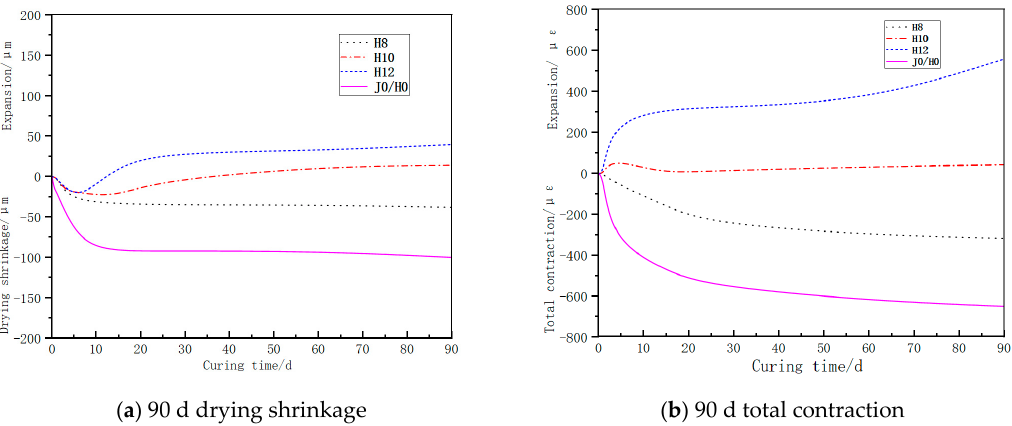
Figure 8. Effects of HPEA on concrete drying and total shrinkage.